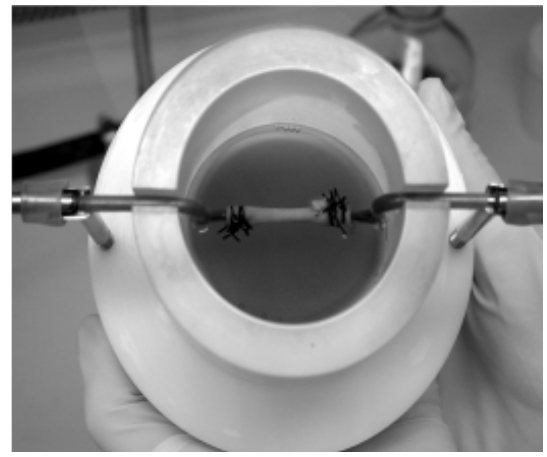
Fig. 1 - Sistema de cultivo “ex vivo” da veia safena